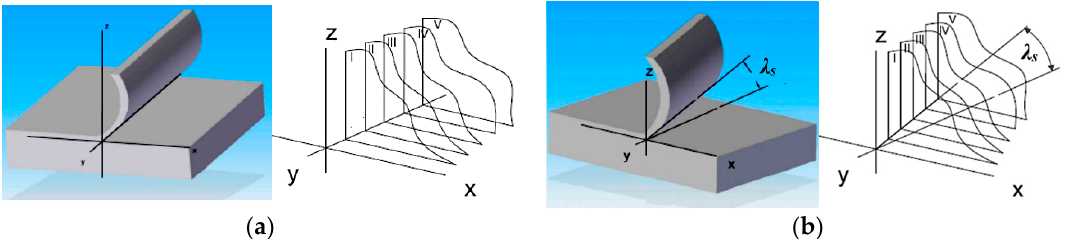
Figure 8. A sample of the chip root for orthogonal cutting with the presentation of individual facet planes, ( a ) λ s = 0°; ( b ) λ s > 0°.